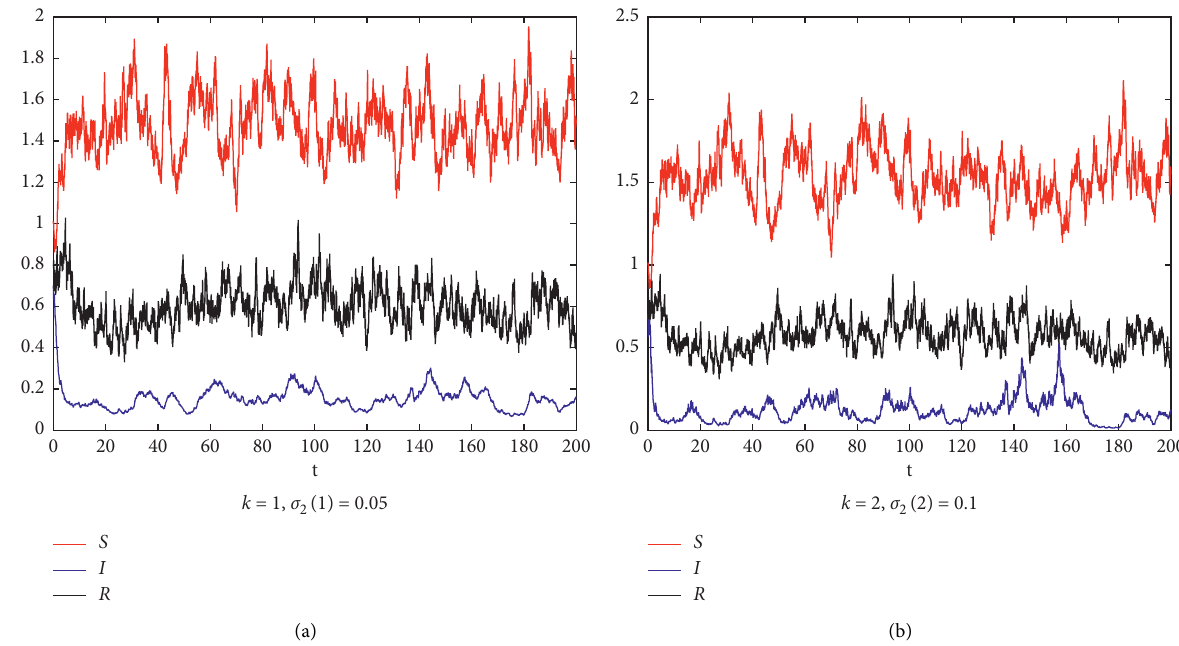
Figure 1: Simulations of the solution ( S ( t ) , I ( t ) ,R ( t )) to stochastic model (2) with ( S ( 0 ) ,I ( 0 ) , R ( 0 )) � ( 1 , 0 . 7 , 0 . 8 ) . (a) k � 1 , σ ( 2 ) � 0 . 1. (b) k � 2 , σ 2